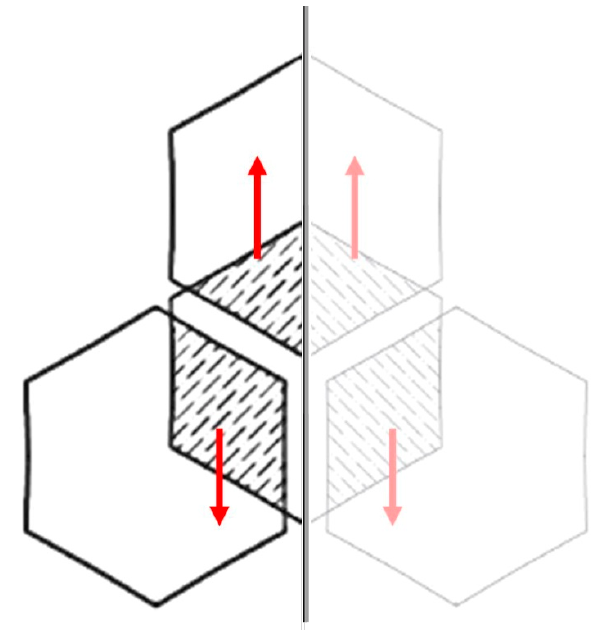
Figure 3. Volume symmetry of hexagonal reinforcement.